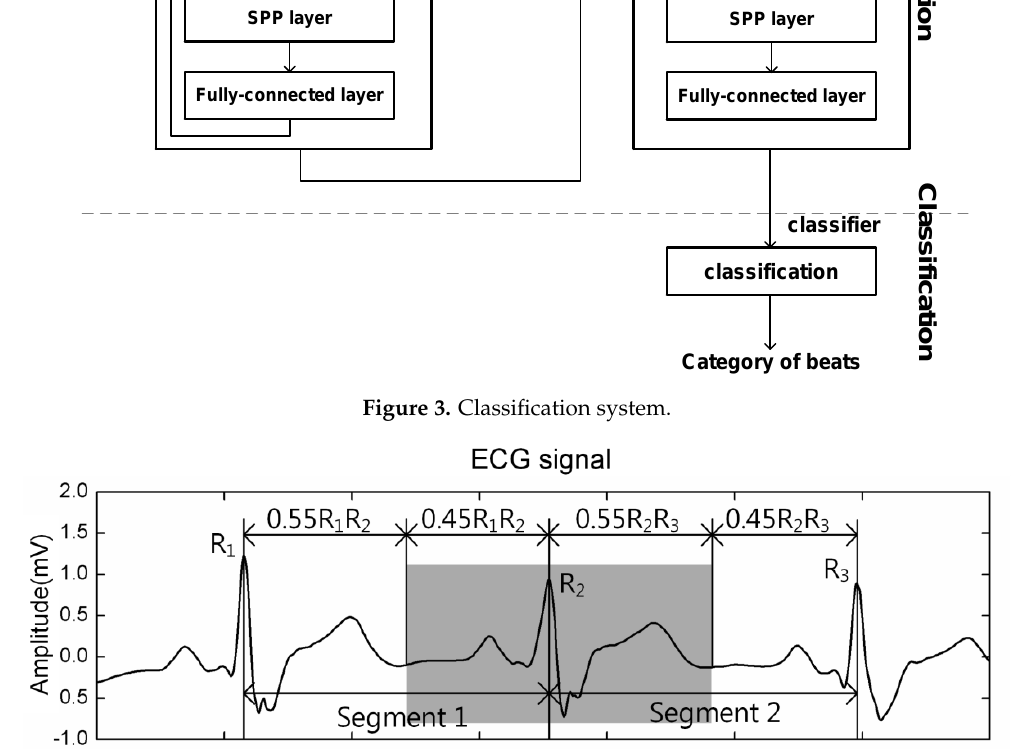
Table 2 . Number of beats in the sample set.